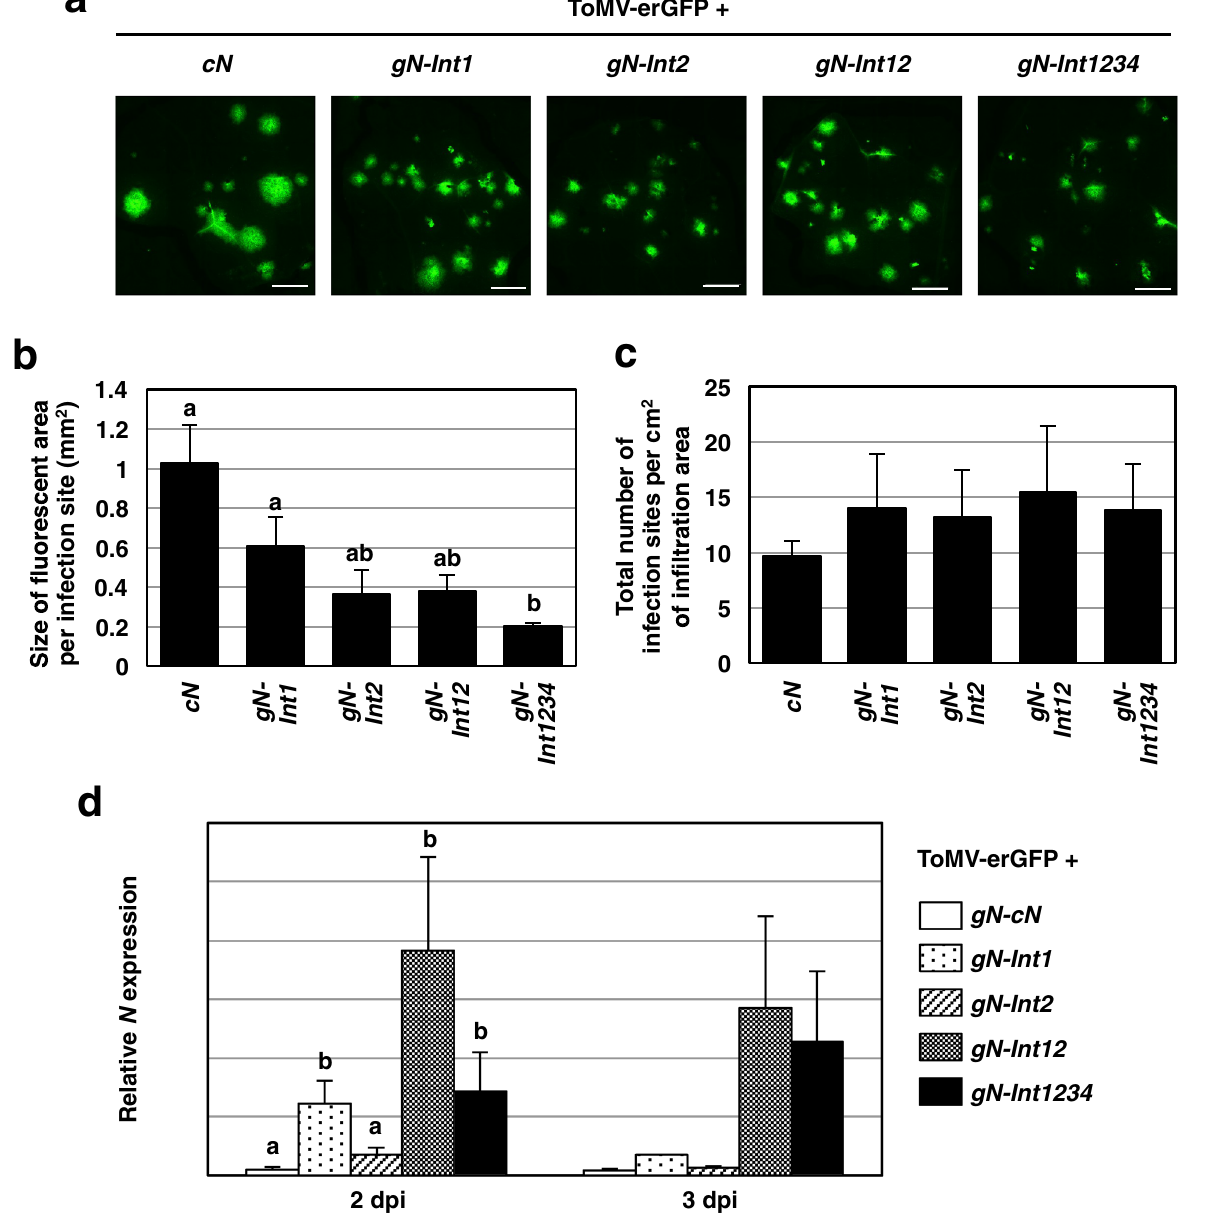
Figure 7. Effects of introns 1 and 2 on N-mediated virus resistance in Nicotiana benthamiana . ( a ) Agrobacterium transformants carrying the indicated N transgene were infiltrated with those carrying the infectious ToMV-erGFP clone into N. benthamiana . Representative fluorescent images taken at 5 days post- infiltration are shown. Bar = 2.5 mm. ( b , c ) The mean size of fluorescent areas per infiltration site and the total number of infection loci per cm 2 were determined for each N transgene. ( d ) N transcript levels were analyzed by qRT-PCR with the F1 + R1 primer set at 2 and 3 days post-infiltration (dpi). Transcript levels of actin were used for normalization of values. Values of ( b ), ( c ) or ( d ) are the means ± SE of, respectively, six or three biological replicates. Data in ( b ) or ( c , d ) (for 2 dpi) were analyzed, respectively, by the Steel–Dwass test (p < 0.05) or a two-way ANOVA test followed by the Tukey–Kramer test (p < 0.05). Different letters above the bars in ( b ) and ( d ) (2 dpi) indicate that the means are significantly different from each other at the 0.05 level. Absence of letters above bars in ( c ) and in ( d ) (3 dpi) indicates no significant difference between